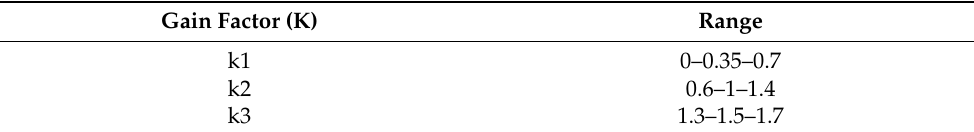
Table 4. Ranges of gain factor